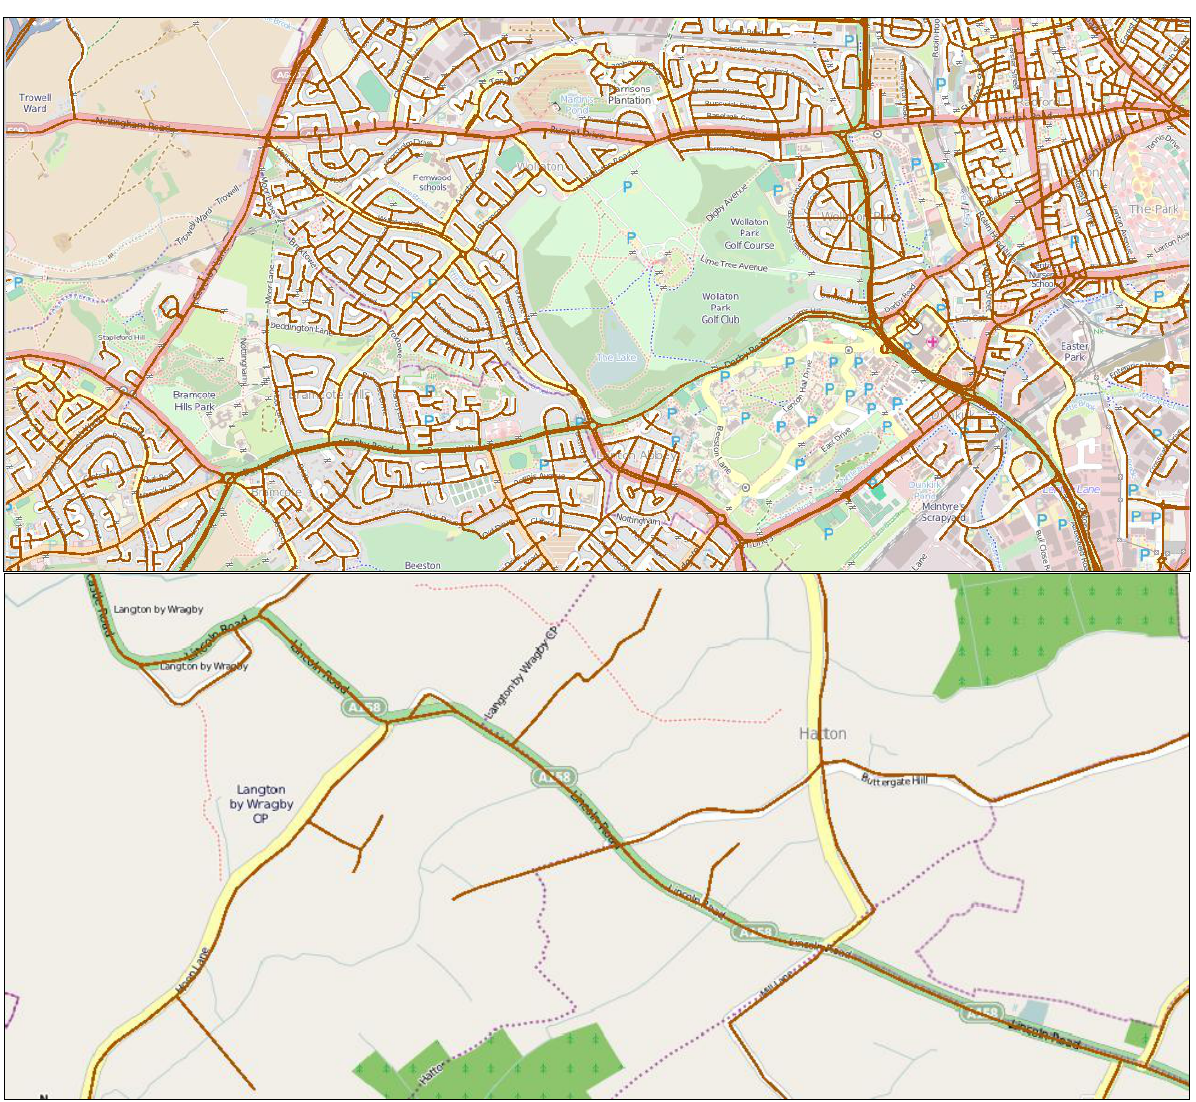
Figure 2. Comparing the completeness level of the road network in VectorMap District (brown) and OpenStreetMap (background) in an urban area (Nottingham city, above ) and a rural area (around Lincoln, below